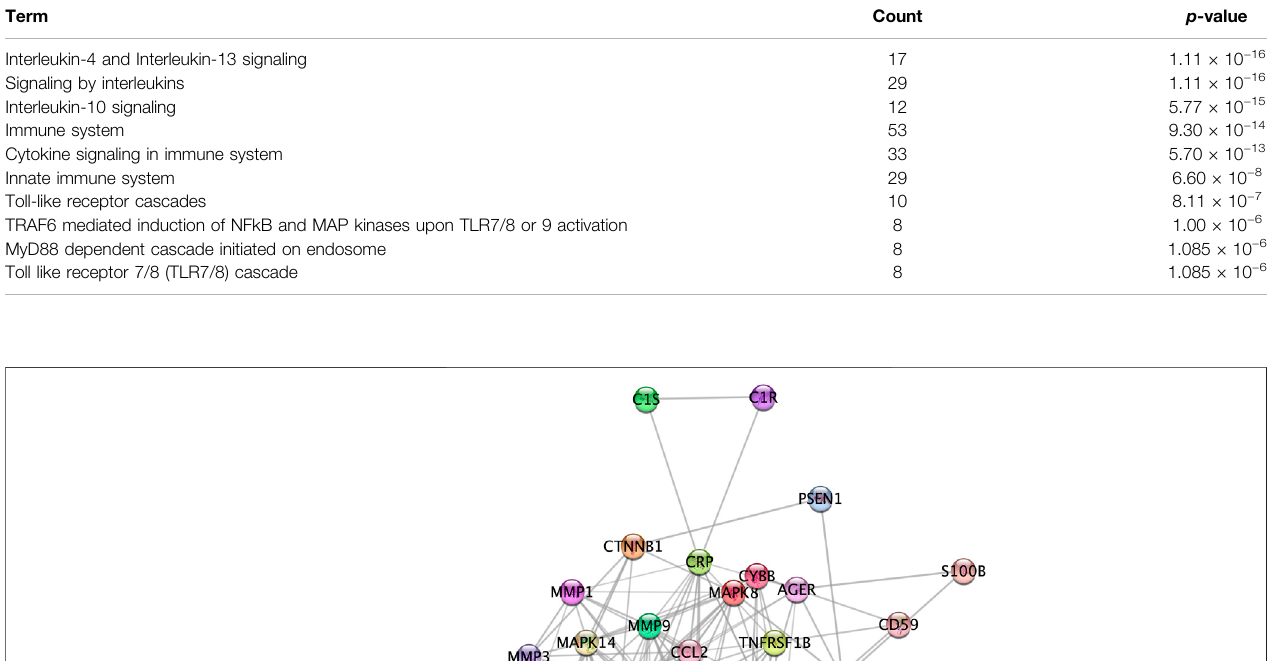
Figure 4 represents the protein-protein functional interaction network of the aforesaid proteins. In this representation, nodes represent proteins and edges represent functional interactions.